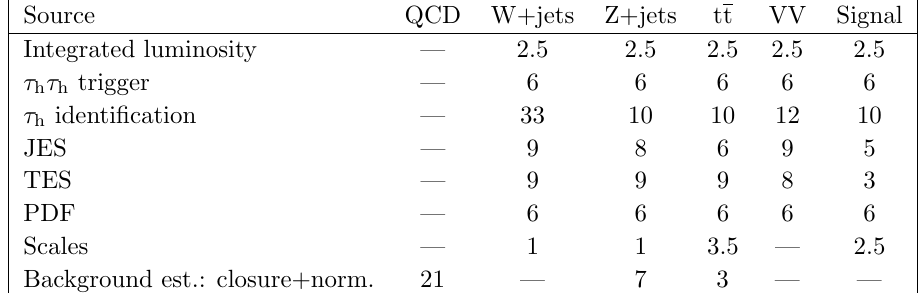
| j 1 ; j 2 ; p miss ) ; 1 ; (cid:28) h ; 2 ; T